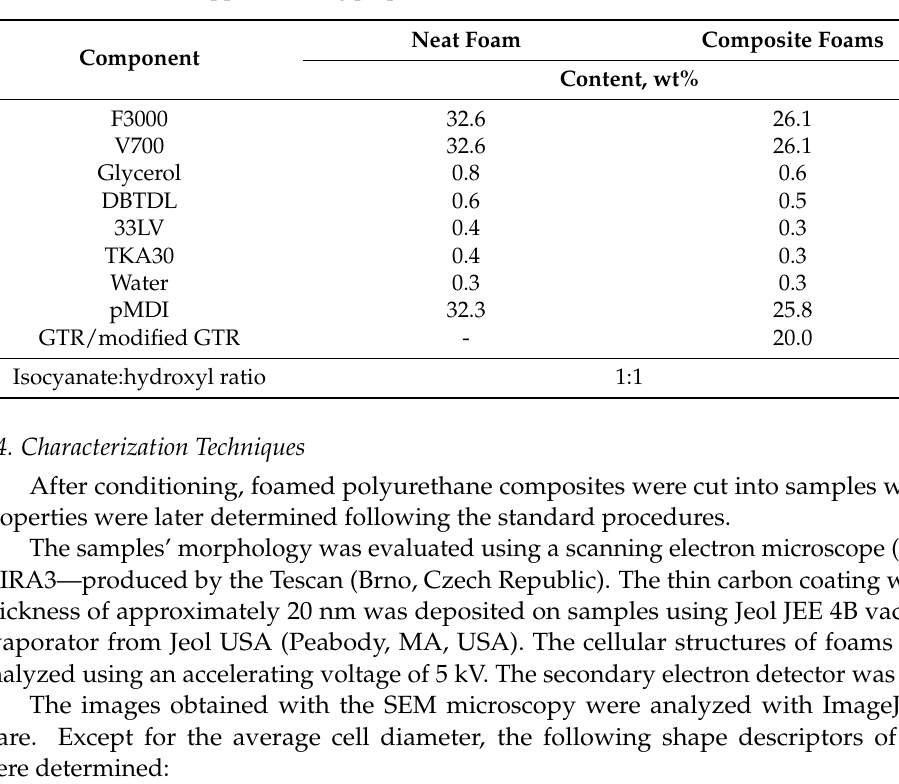
Table 3. Formulations applied during preparation of